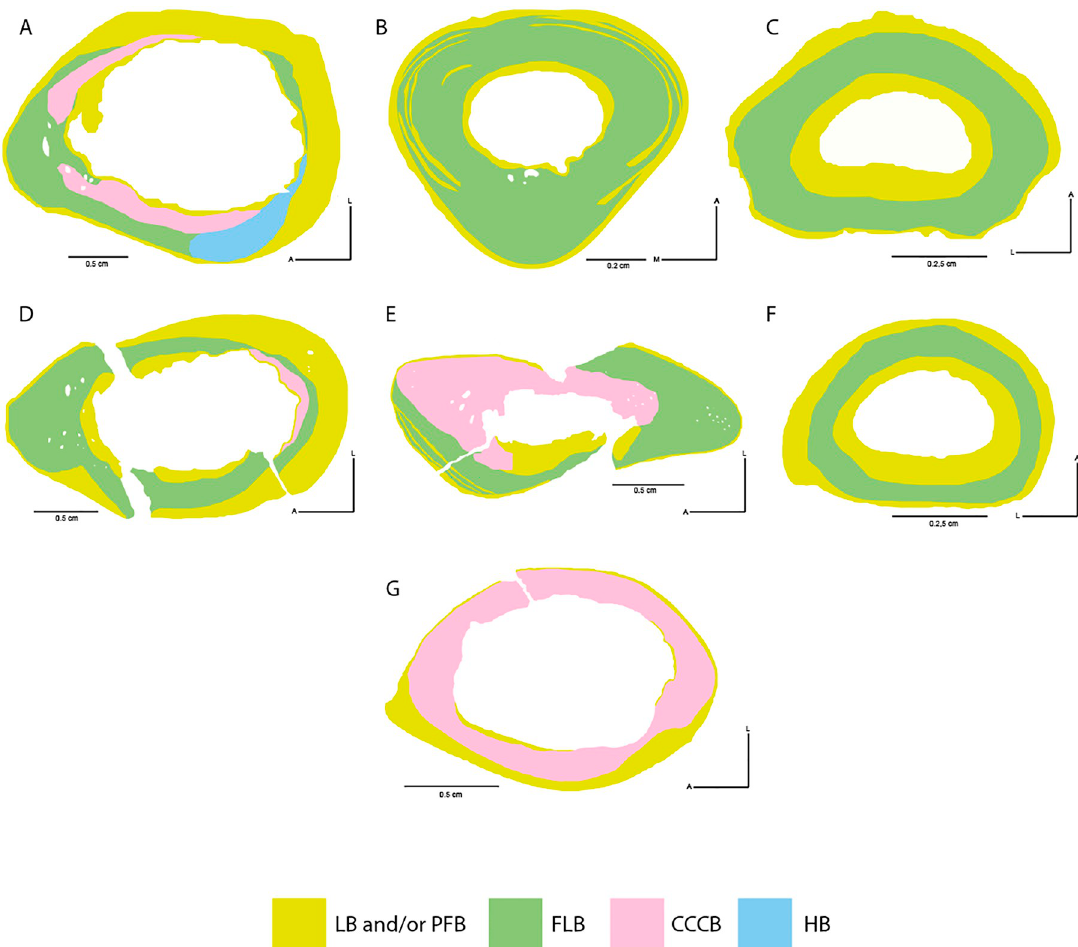
Fig 11. Types of bone tissue in section of Caraguatypotherium munozi from the middle Miocene of Caragua, Huaylas formation. Individual 1 (HUAY15-100): A, B and C, Individual 2 (HUAY 15–200): D, E and F, Individual 3 (HUAY17-05): G. (A) Left humerus (GEOUACH.HS.HI.1); (B) Left Metacarpal III (GEOUACH.HS.MTC.1); (C) 1 st left phalange (GEOUACH.HS.PFI.1); (D) Right humerus (GEOUACH.HS.HD.1); (E) Right ulna (GEOUACH.HS.UD.1); (F) 1 st left phalange (GEOUACH.HS.PFD.1); (G) Left humerus (GEOUACH.HS.HI.2). For abbreviations refer to Fig